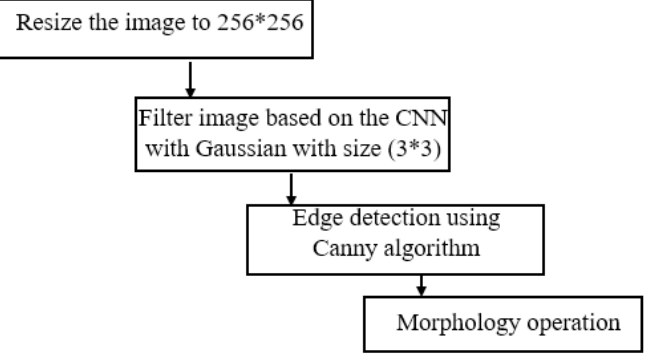
Figure 1. Block diagram of fingerprint image pre-processing.